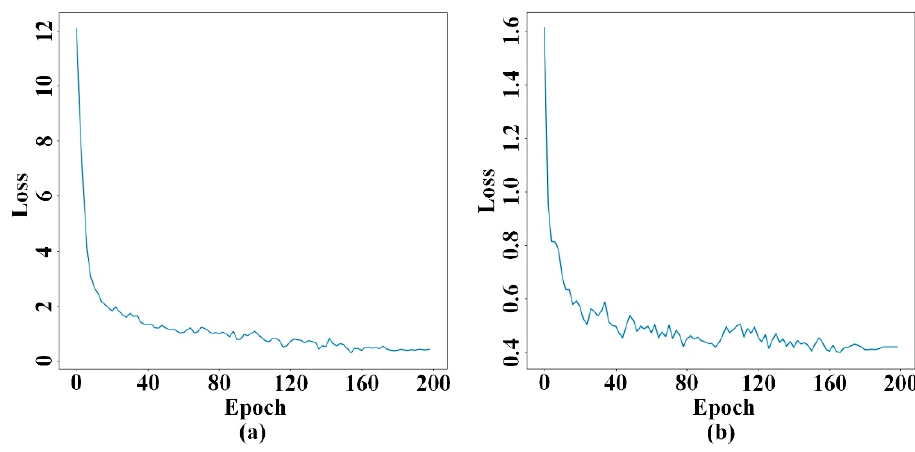
Figure 8. MSE loss curves of the proposed CNN-LSTM model. ( a ) Loss curve of the training dataset. ( b ) Loss curve of the testing dataset.